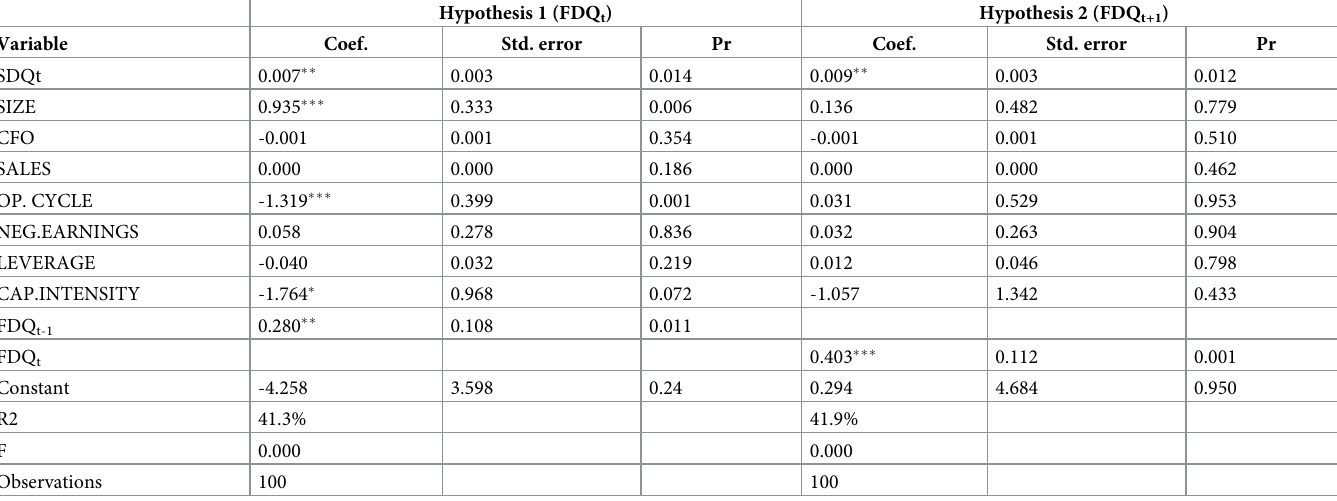
Table 7. Relationship between accrual earnings disclosure quality and sustainability disclosure